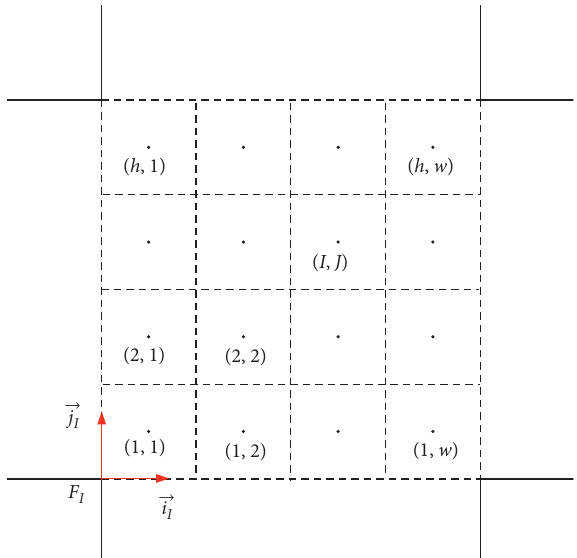
Figure 2: Grid array of the IR and its double index ordering. The enumeration of the array starts from the lower left cell of the grid